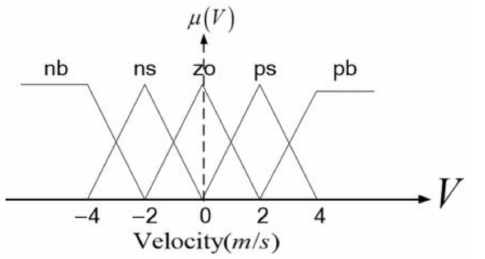
Figure 13. Membership functions for characterizing the target–quadcopter relative speed.